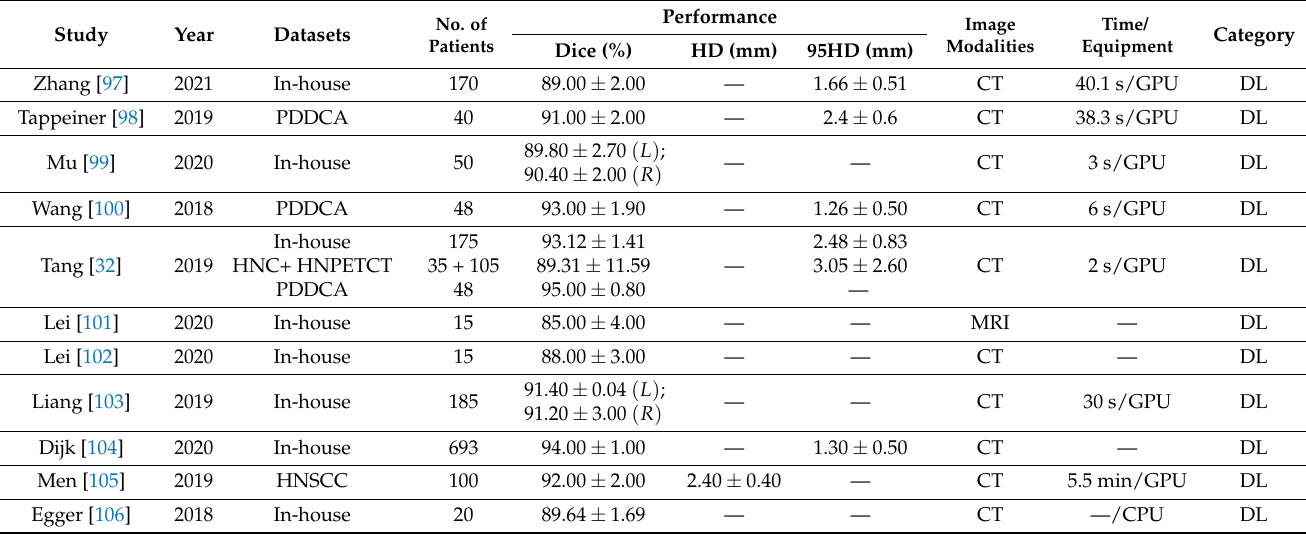
Table 11. Summary of two-stage strategies in deep learning-based